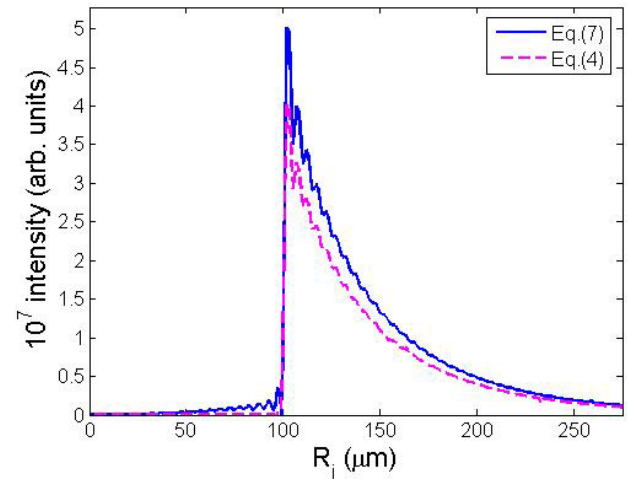
FIG. 5. (Color) Comparison of PSF of ODR obtained from Eq. (4) and that from Eq. (7). The parameters used are (cid:3) (cid:3) 2000 , (cid:4) (cid:3) 0 : 5 (cid:8) m , and M (cid:3) 1